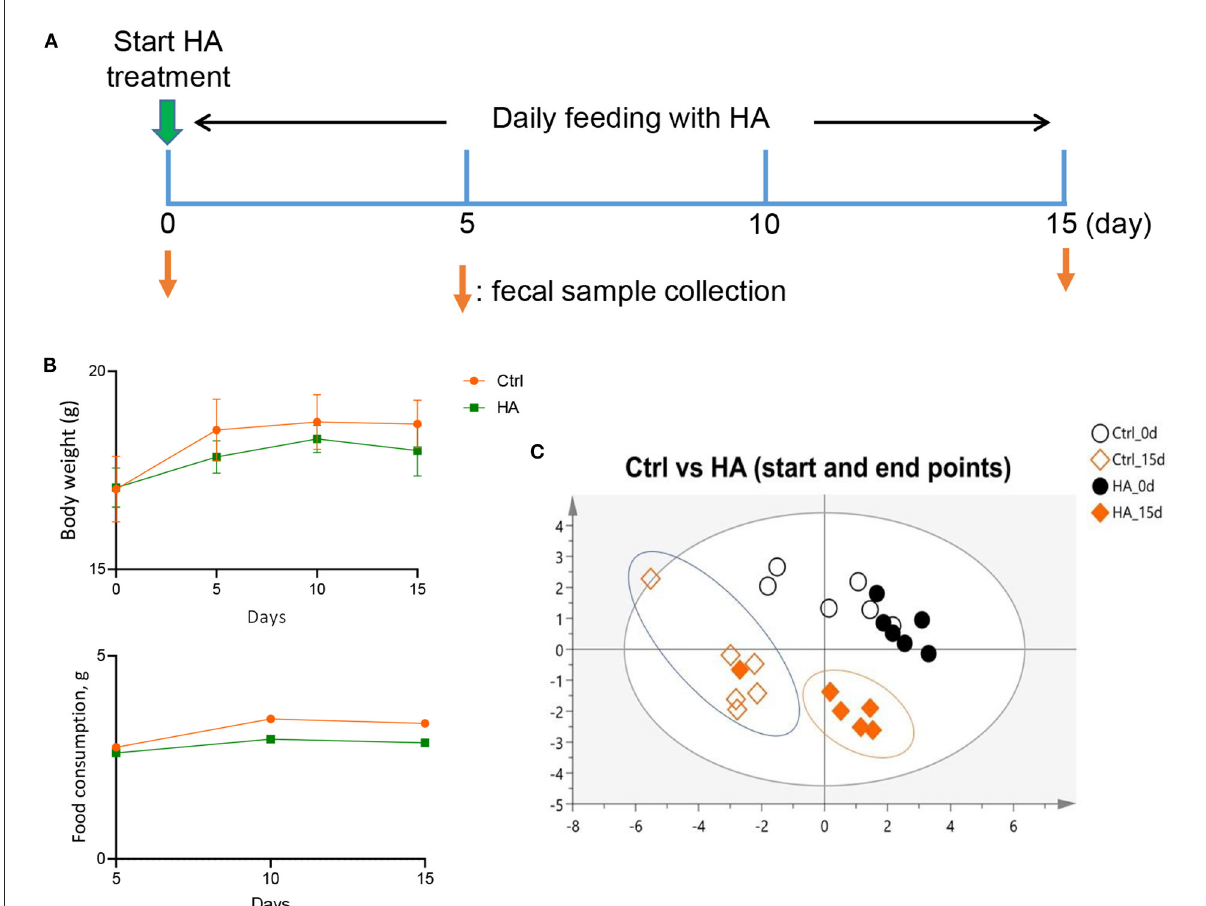
FIGURE1 Effect of HA treatment on GM profile of C57BL/6 mice. (A) The HA treatment schemes. (B) The profiles of food consumption and body weight. (C) The similarity of the GM profile of the treatment groups was analyzed by ERIC-PCR and plotted with PLS-DA tool. n = 6.